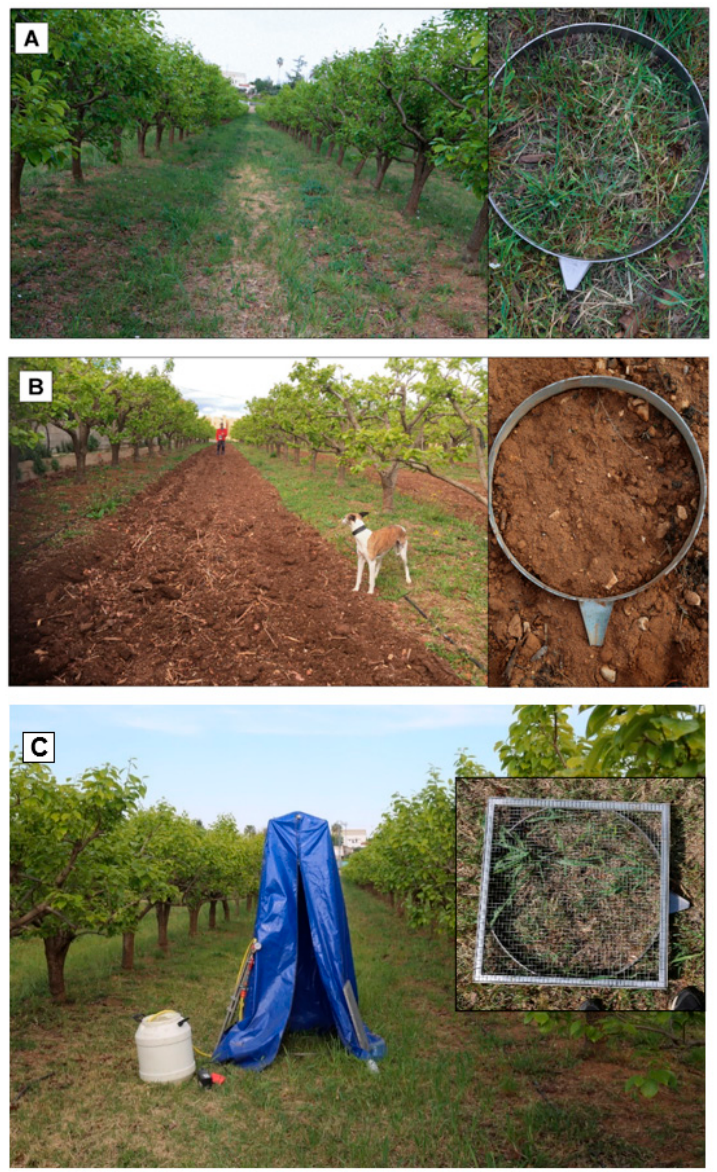
Figure 3. View of the No-Tillage with ground cover ( A ) and Tillage ( B ) plots with a detail of the ring subplots for the rainfall simulator. A view of the rainfall simulator and the measurement of the soil surface cover device is shown ( C